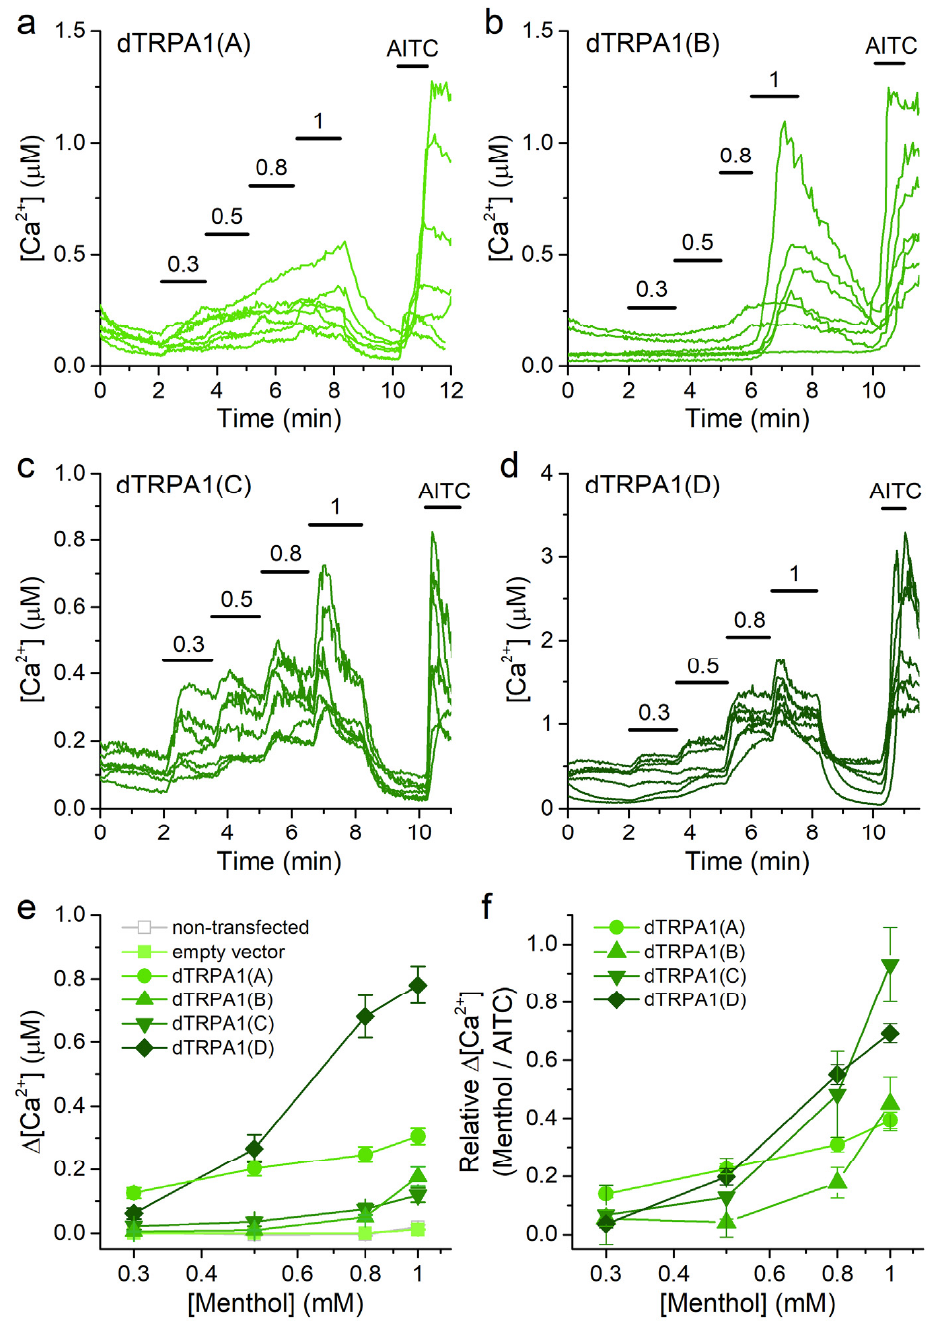
Figure 5. Menthol increases intracellular Ca 2+ in cells transfected with dTRPA1 isoforms. ( a – d ) Example traces of changes of intracellular Ca 2+ concentration induced by menthol (0.3–1 mM) and AITC (100 µ M) in HEK293T cells expressing: dTRPA1(A), dTRPA1(B), dTRPA1(C) or dTRPA1(D). ( e , f ) Concentration dependence of the average amplitude of intracellular Ca 2+ increase induced by menthol; panel ( e ) raw data and panel ( f ) data obtained by normalizing to the amplitude of the response to AITC in each cell. n = 127, 210, 43 and 65 for isoforms A to D, respectively. We confirmed the activation of all dTRPA1 isoforms by menthol (1 mM) using whole- cell patch-clamp recordings (Figure 6). The maximal amplitude of outward currents evoked by menthol were the highest for dTRPA1(A) and dTRPA1(D), followed by dTRPA1(C) and were the lowest for dTRPA1(B). Menthol-induced currents were reversibly blocked by the application of the TRPA1 inhibitor HC-030031 (100 µM; Figure 6a-d). However, the inhibitory effects of this compound on the menthol-induced currents were weaker than on those elicited by citronellal. Taken together, our results show that all dTRPA1 isoforms respond to menthol in a concentration-dependent and reversible manner.